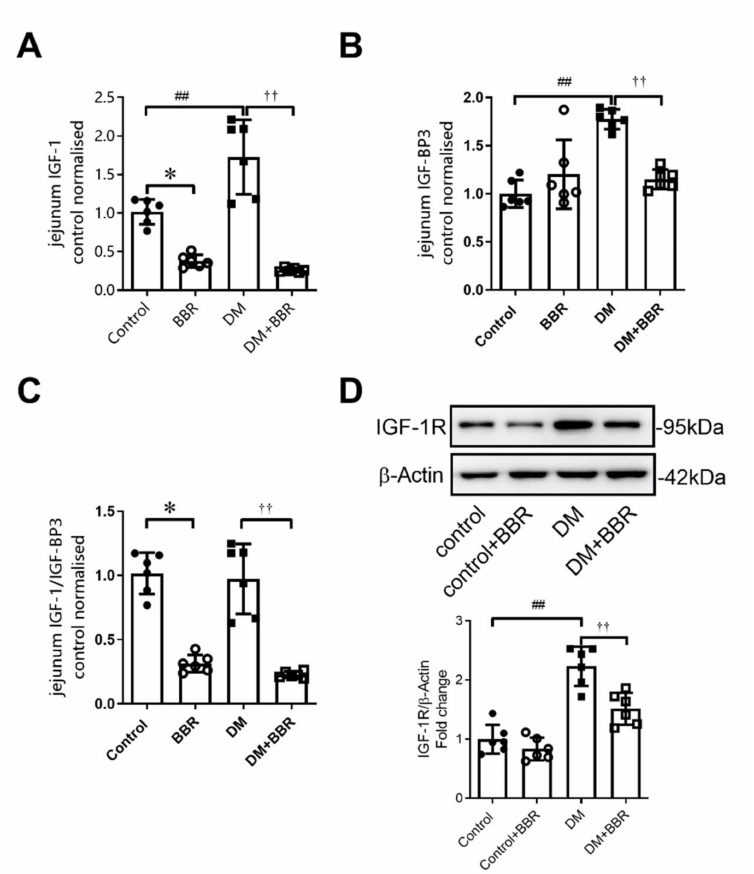
Figure 5. Berberine treatment (200 mg · kg − 1 · day − 1 , BW) for 6 weeks decreased intestinal IGF-1, IGFBP-3 levels, and IGF-1R expression in diabetic mice. ( A – C ) Intestinal IGF-1, IGFBP-3, and IGF-1/IGFBP-3 were decreased in diabetic mice after berberine treatment (200 mg · kg − 1 · day − 1 , BW) for 6 weeks. ( D ) Intestinal IGF-1R expression were decreased in diabetic mice after berberine treatment (200 mg · kg − 1 · day − 1 , BW) for 6 weeks. Data are expressed as mean ± SEM ( n = 6). Control, control mice; Control + BBR, control mice treated with berberine (200 mg · kg − 1 · day − 1 gavage), DM, diabetic mice; DM + BBR, diabetic mice treated with berberine (200 mg · kg − 1 · day − 1 gavage). Control vs. Control + BBR, * p < 0.05; Control vs. DM, ## p < 0.01; DM vs. DM + BBR, †† p <